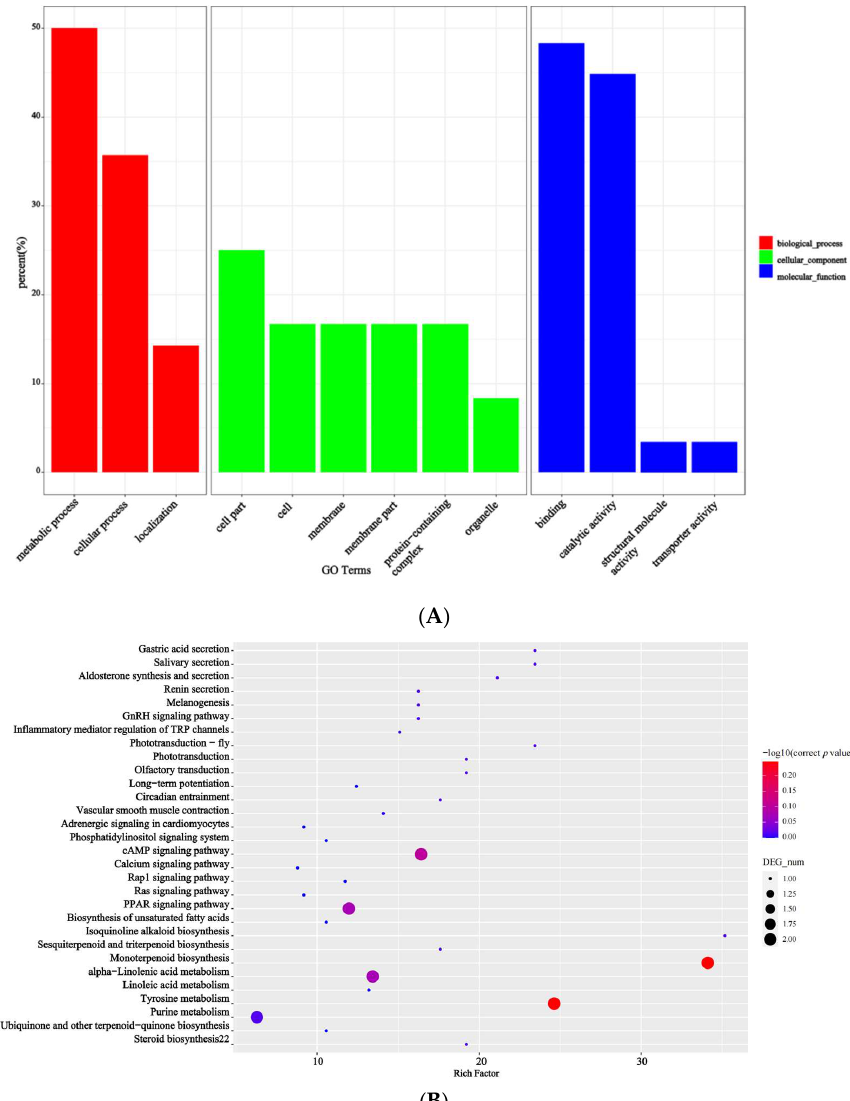
Figure 3. The enriched GO and KEGG terms of the differential expression of transcripts. ( A ) The enriched GO terms of the differential expression of transcripts. ( B ) The enriched KEGG terms of the differential expression of transcripts.